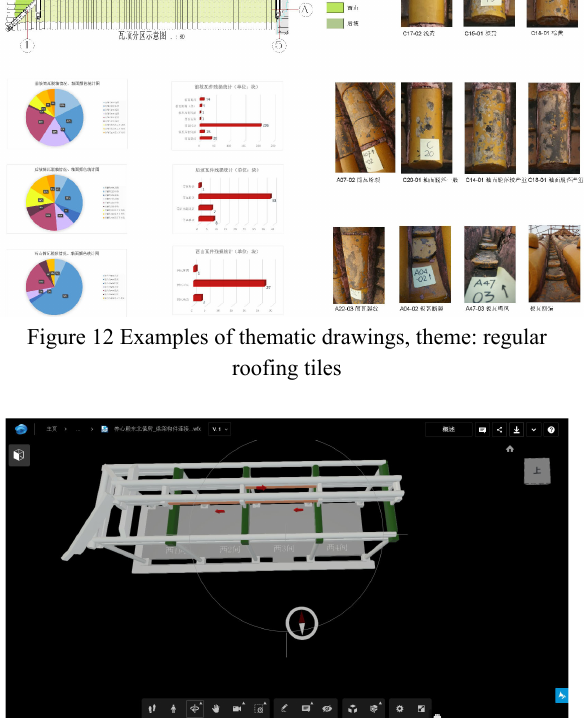
Figure 13 Example of thematic 3D view in A360; theme: problems of structural components joints